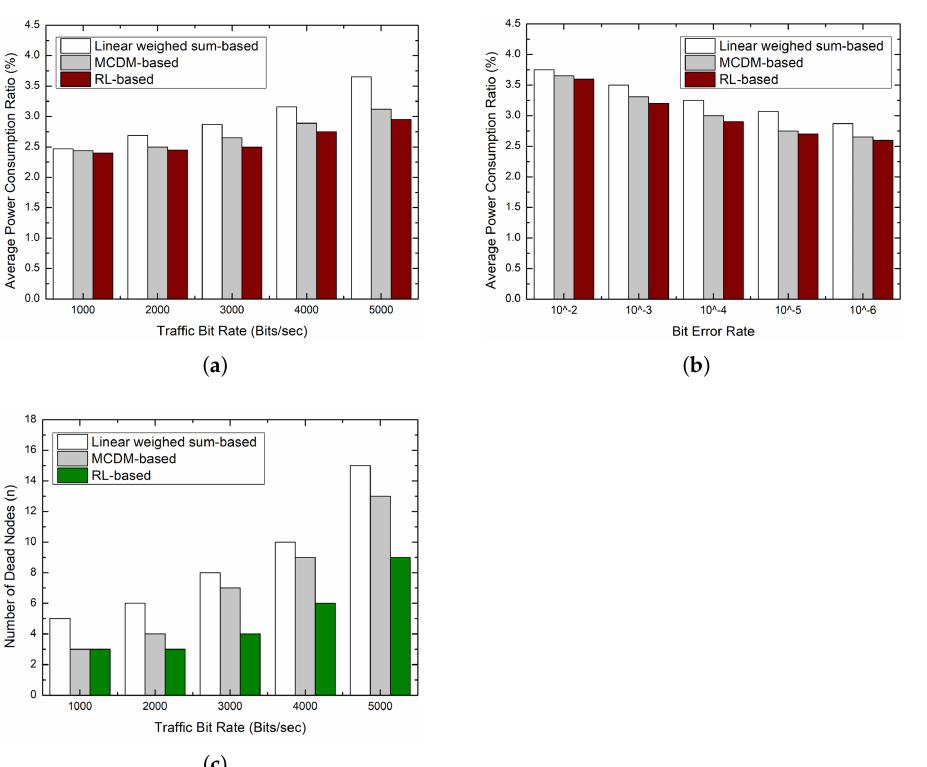
Figure 7. Simulation results: power consumption ratio. ( a ) Power consumption ratio according to traffic bit rate; ( b ) Power consumption ratio according to bit error rate; ( c ) Number of dead nodes according to traffic bit